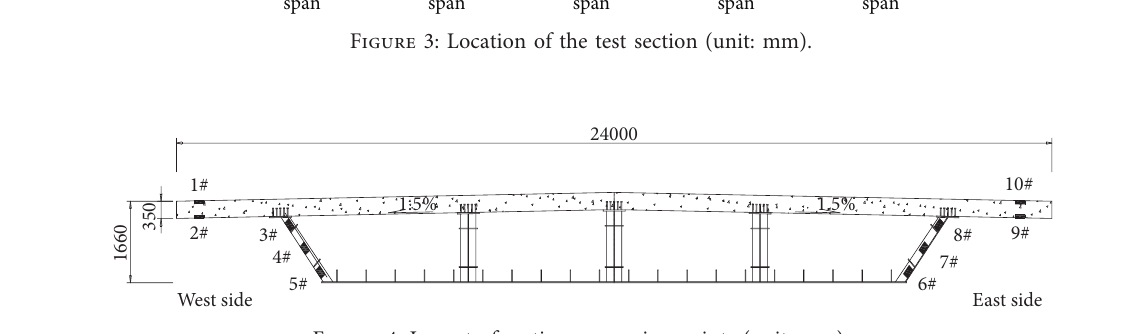
Figure 4: Layout of section measuring points (unit: mm). Table 1: Meteorological data